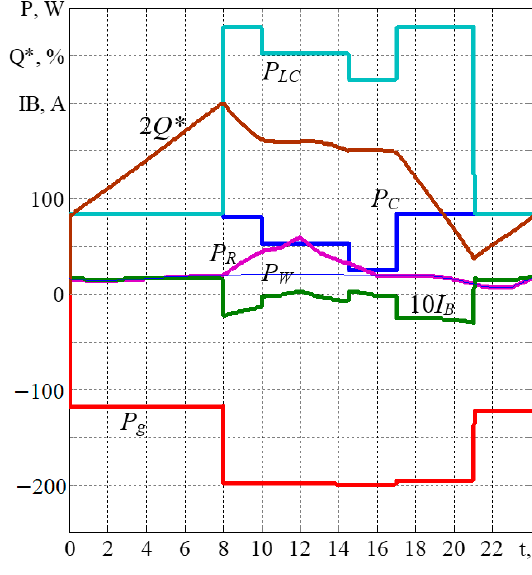
2 = 35%; ( b ) Q* 2 = 52% ( P LC , load power; P C , load added power; P R , the actual power of RES; P g ,